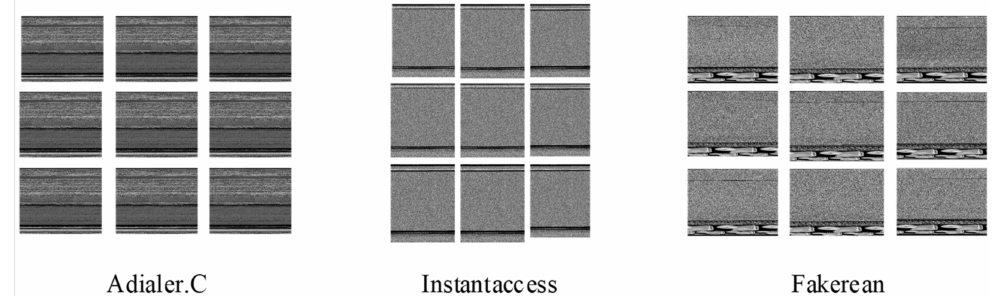
Figure 2. Malware samples after visualization from different families.